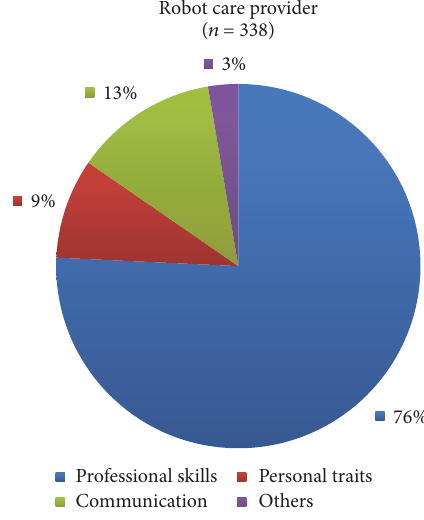
Figure 2: Trust factors across all